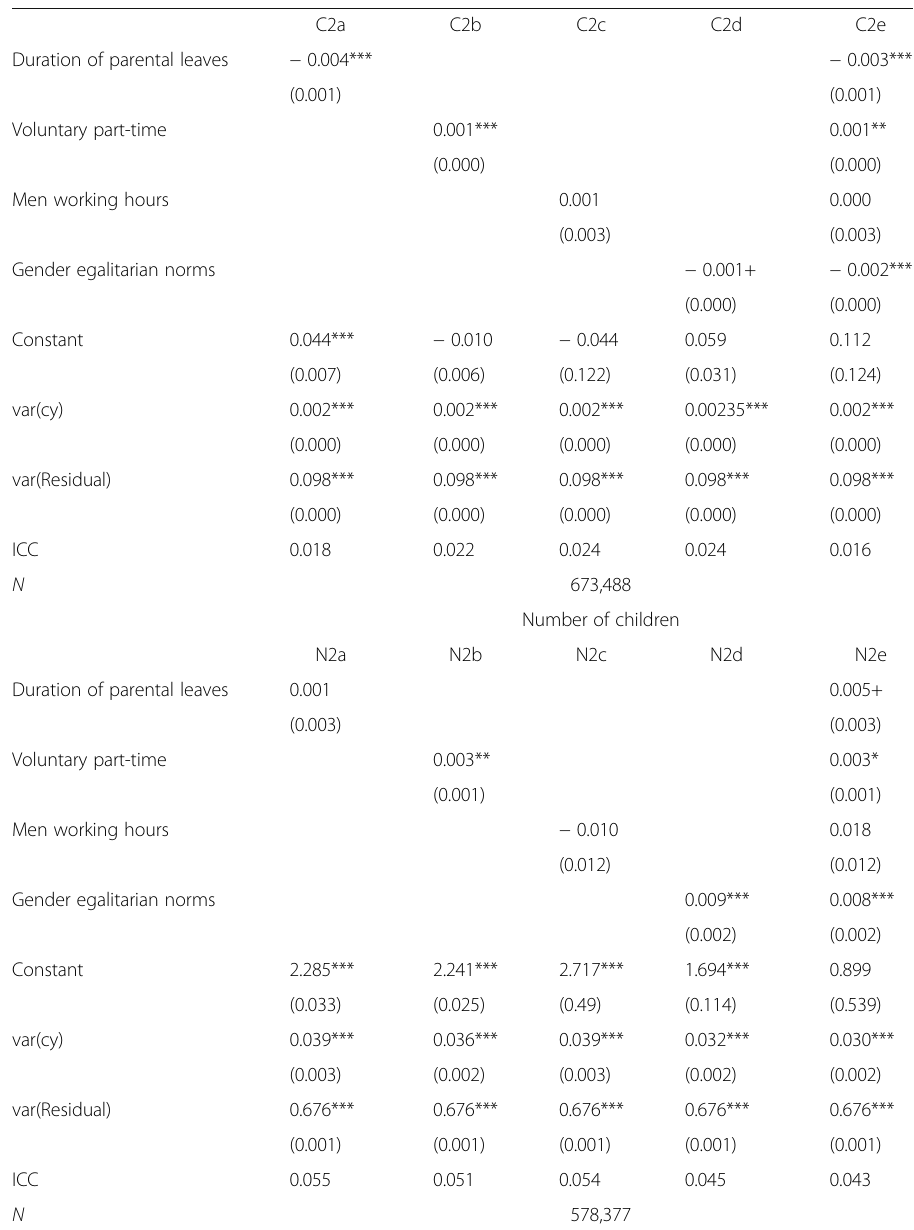
Table 3 Multilevel regressions of country level predictors on childlessness (top table) and number of children (bottom